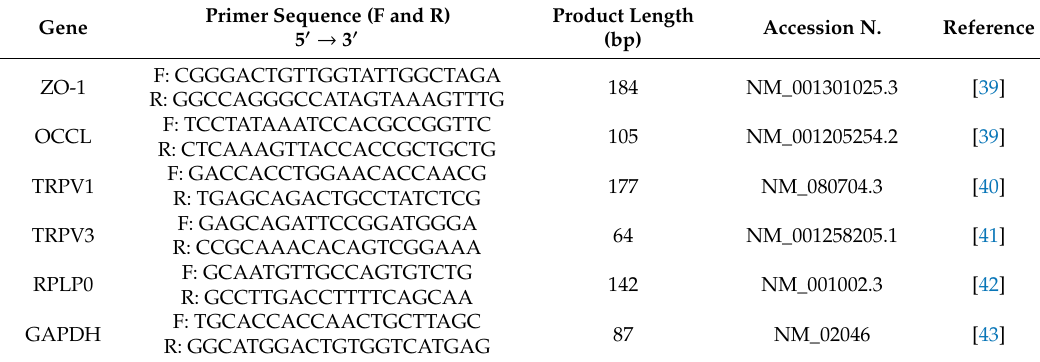
Table 1. Primers used for gene expression analysis.